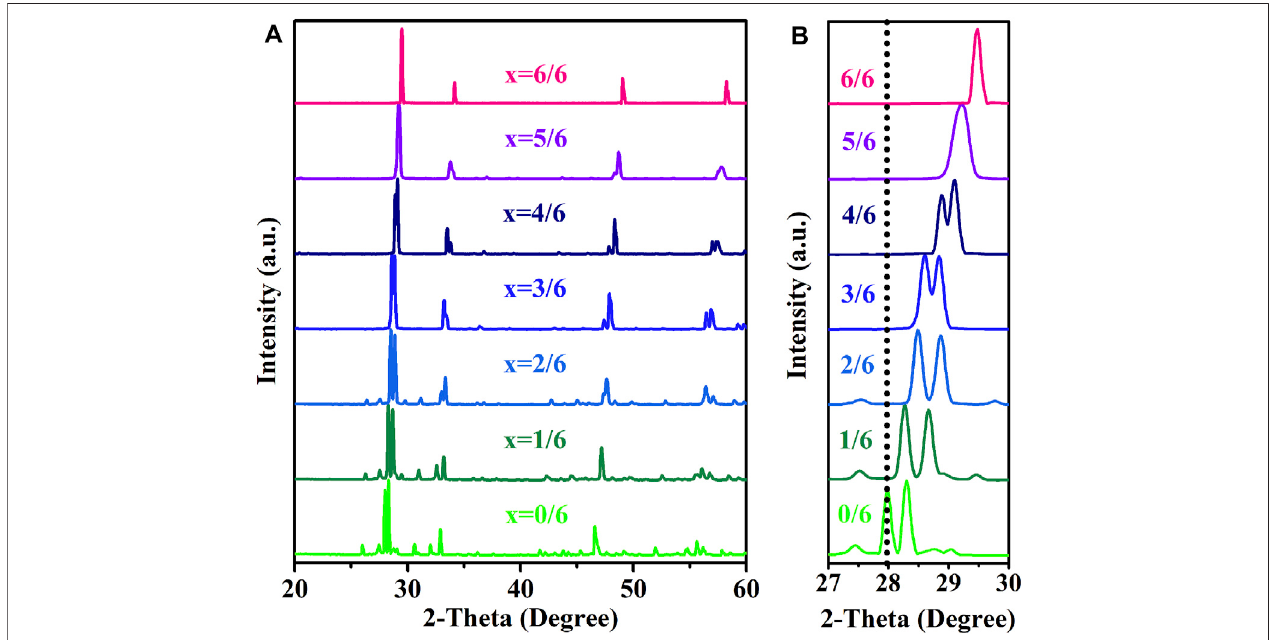
FIGURE 1 | The normalized XRD peaks of (La 1-x Ho x ) 3 NbO 7 ( x (cid:2) 0/6, 1/6, 2/6, 3/6, 4/6, 5/6, and 6/6) ceramics: (A) 20 ˚ ≤ 2-Theta ≤ 60 ˚ and (B) 27 ˚ ≤ 2-Theta ≤ 30 ˚ .